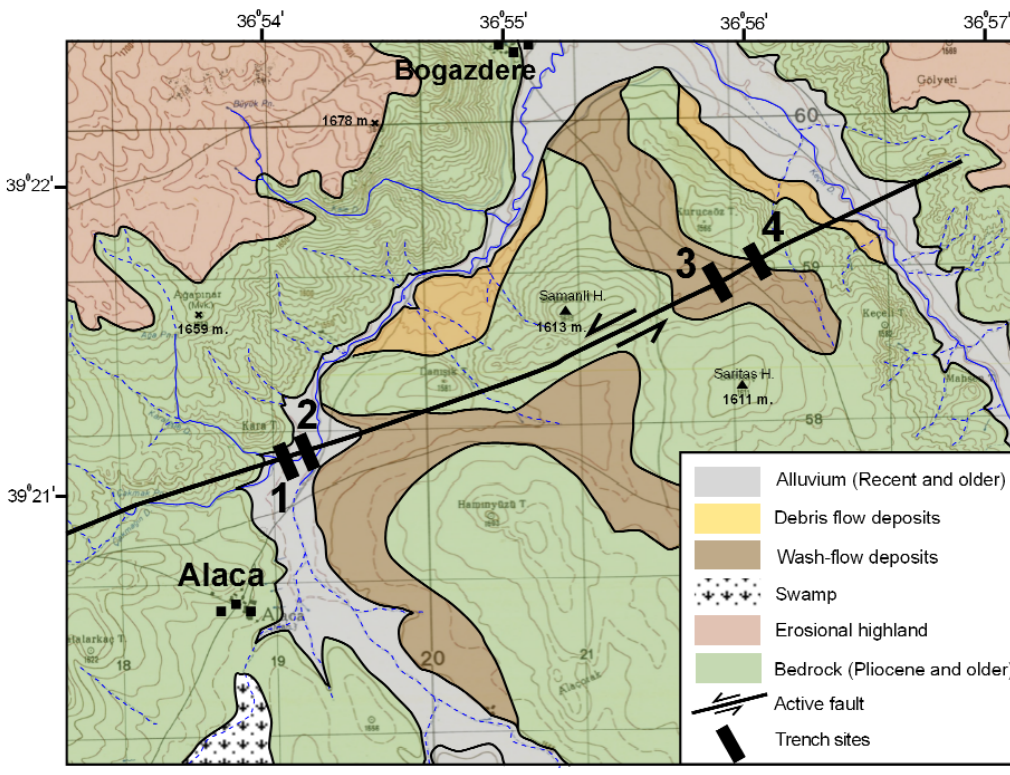
Figure 5. Geomorphological map of the investigation area. See key for